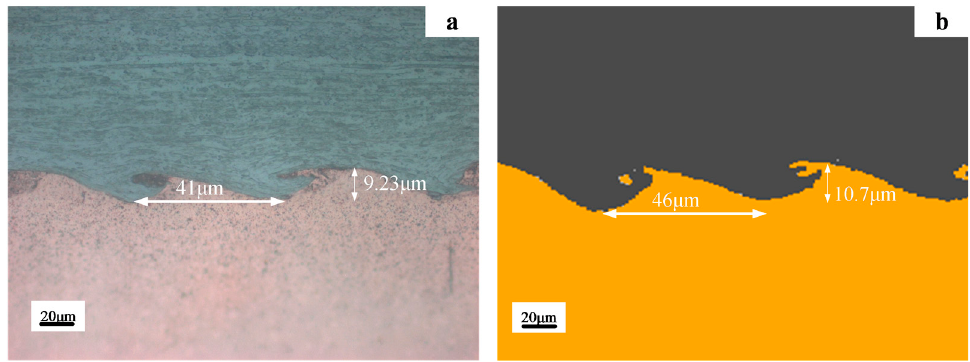
Figure 12. Comparison of experimental and numerical results for T-6 with impact velocity of 639.8 m/s: ( a ) experimental result; ( b ) numerical result.